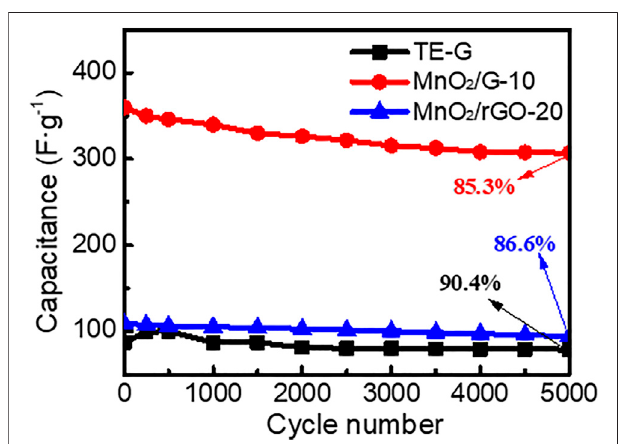
FIGURE 8 | Cycling stability of TE-G, MnO 2 /G-10and MnO 2 /rGO-20 composites electrode tested in three-electrode